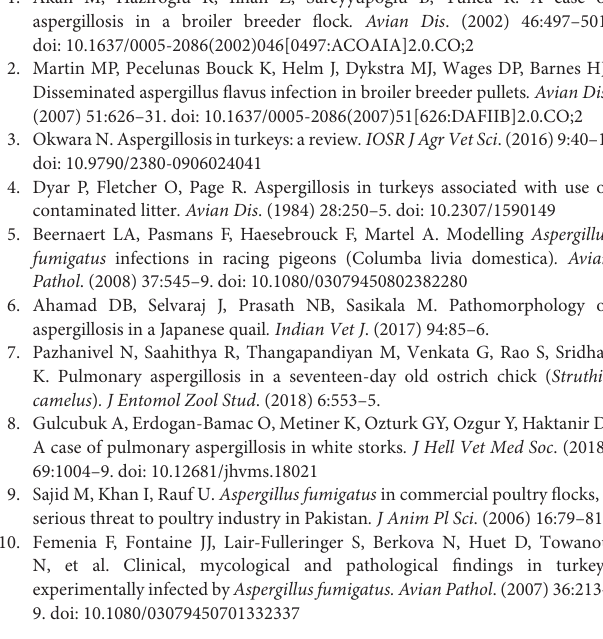
Supplementary Figure 1 | Gross lesions of air sacs and lungs infected with Aspergillus fumigatus . (A) At 1 dpi, slight thickness, turbidity and a small amount of yellow white exudate in air sac; (B) At 3 dpi, yellow white exudate increased in air sac; (C) At 5 dpi, a large amount of yellow white caseous exudate in air sac; (D) Clean and transparent in normal air sac; (E) At 1 dpi, focal edema and hemorrhage in the lung; (F) At 3 dpi, the lesions size increased, with edema and hemorrhage in the lung; (G) At 5 dpi, yellow white necrosis in the majority of lung; (H) Normal